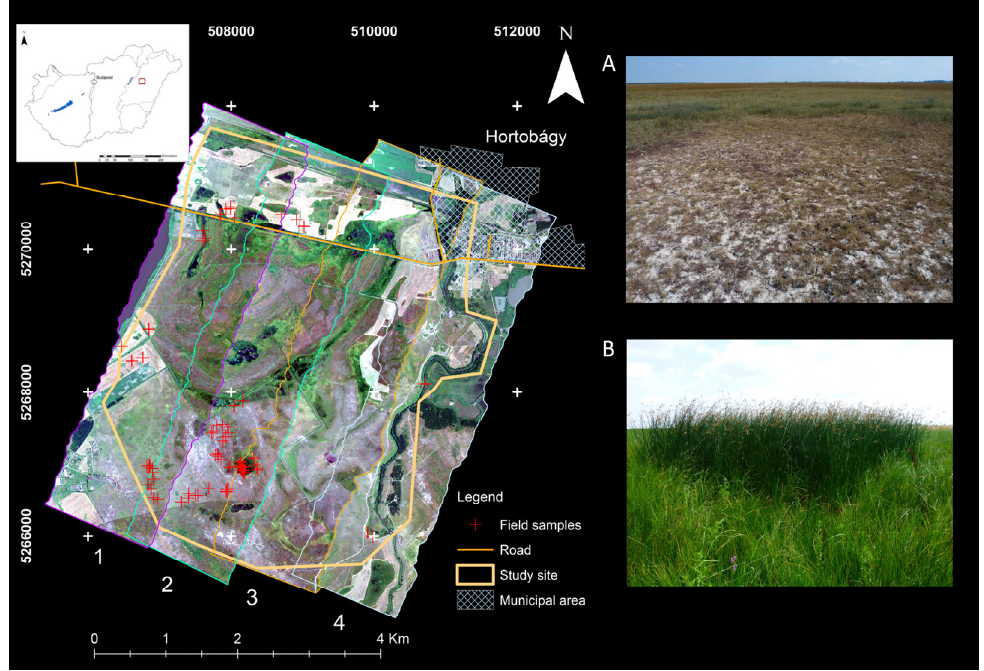
Figure 1. Overview map of the study site (Pentezug-puszta). Projection of the image is WGS 84 UTM 34 North. Red cross marks indicate the positions of field measurement